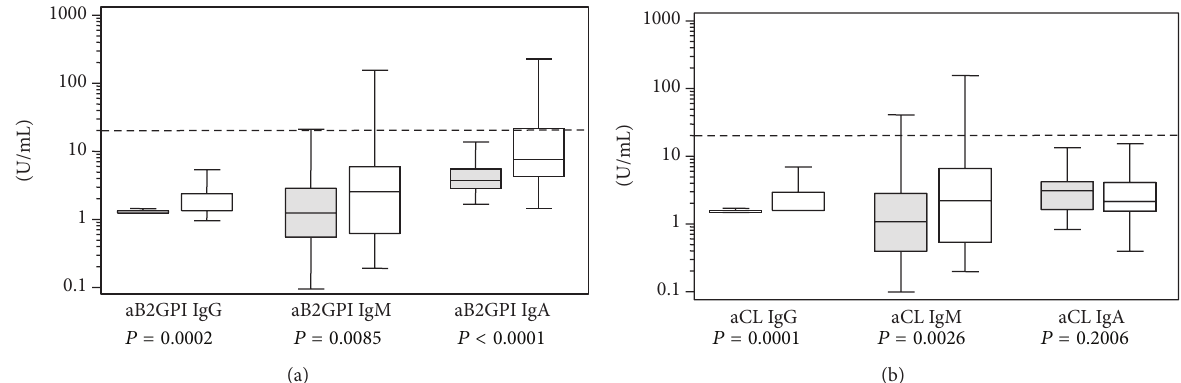
Figure 1: (a) Levels of anti-Beta 2 Glycoprotein I antibodies (aB2PGI) in controls (gray) and C-APS patients (white). (b) Levels of anticardiolipin antibodies (aCL) in controls (gray) and C-APS patients (white). Cutoff is indicated by a dotted line.